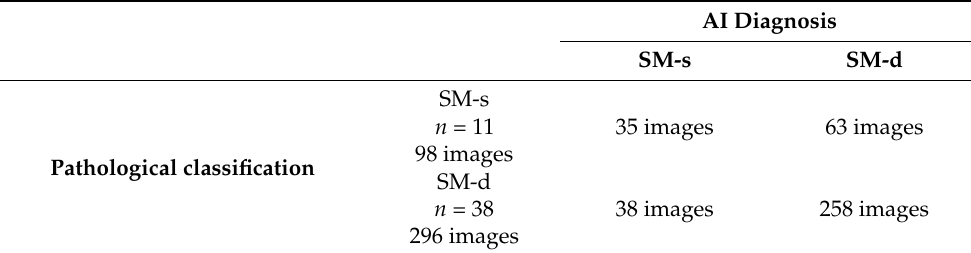
Figure 3. Receiver operating characteristics curve. ( A ) The area under the curve value of the learning set was 0.971. ( B ) The area under the curve value of the validation set was 0.758. Table 3. Results of CNN learning from the validation set.